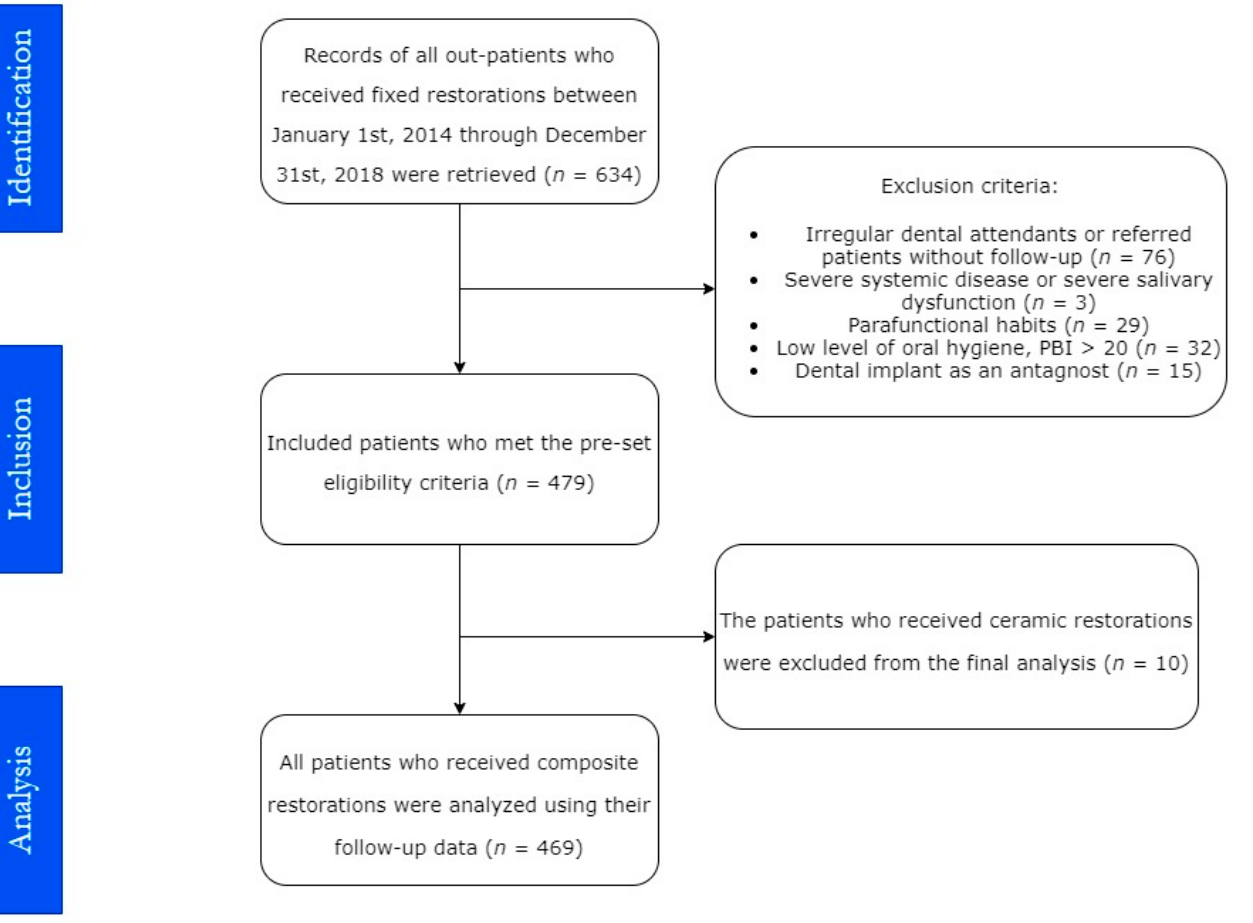
Figure 1. Flowchart of the study on composite restoration recipients, Palacky University Hospital, 2014–2018 ( n = 469).